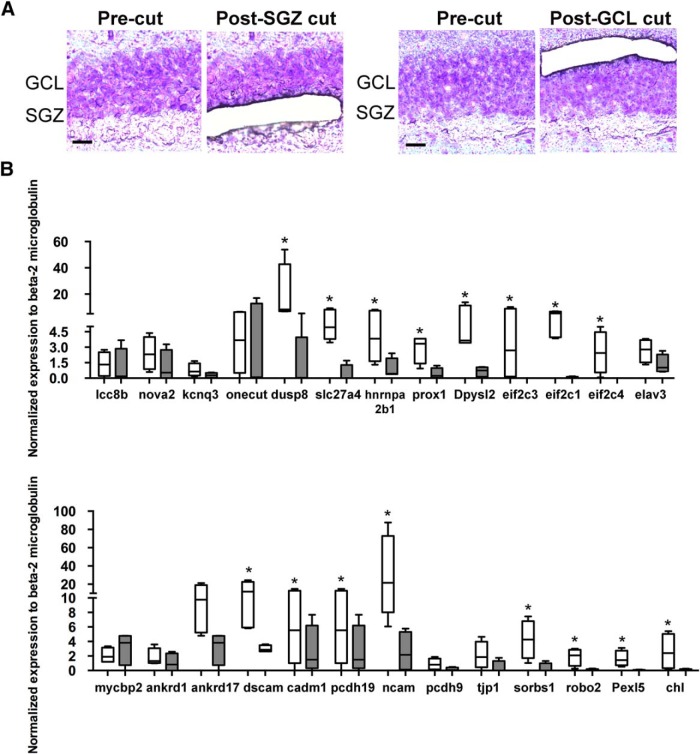
Validation by RT-PCR of TU-tagging target genes in tissue obtained by laser capture microdissection. A, Sequential images of SGZ (two left panels) and GCL (right two panels) show the subregion microdissected by laser capture from cresyl violet-stained dentate gyri. Scale bar, 12 μm. The regions were chosen to show enrichment of immature and mature granule cells, respectively. B, qPCR results from laser-captured tissue showed upregulation in the SGZ (white rectangles) compared with the GCL (gray rectangles) in 62% of the selected genes (16 of 26 genes), mRNA levels were normalized to β2-microglobulin. *p < 0.05, n = 5).